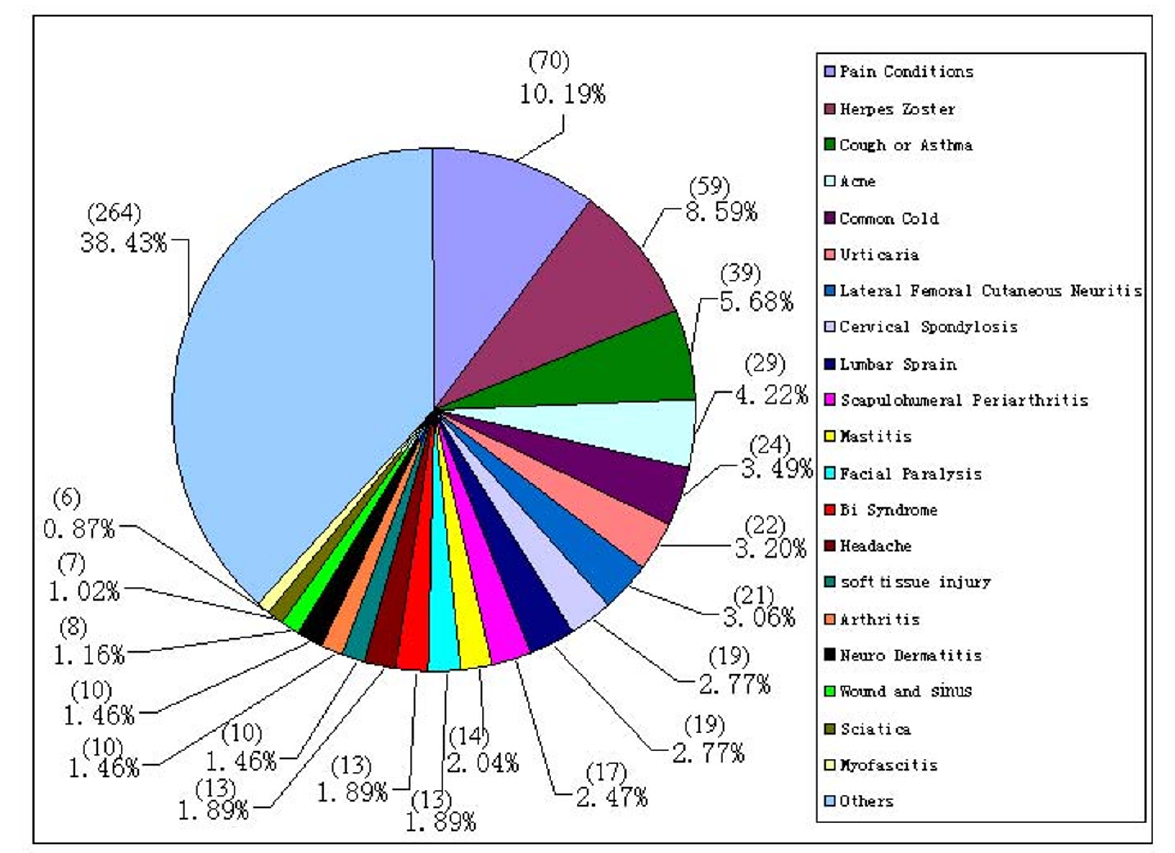
domization (Table 1: Reporting of five quality compo- nents in randomized clinical trials on cupping therapy).